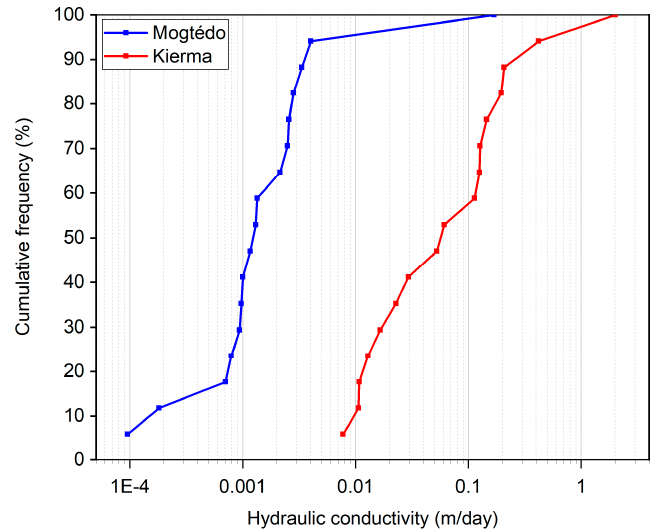
Figure 13. Cumulative frequency of hydraulic conductivity of the shallow aquifer of the Mogtédo and Kierma watershed.